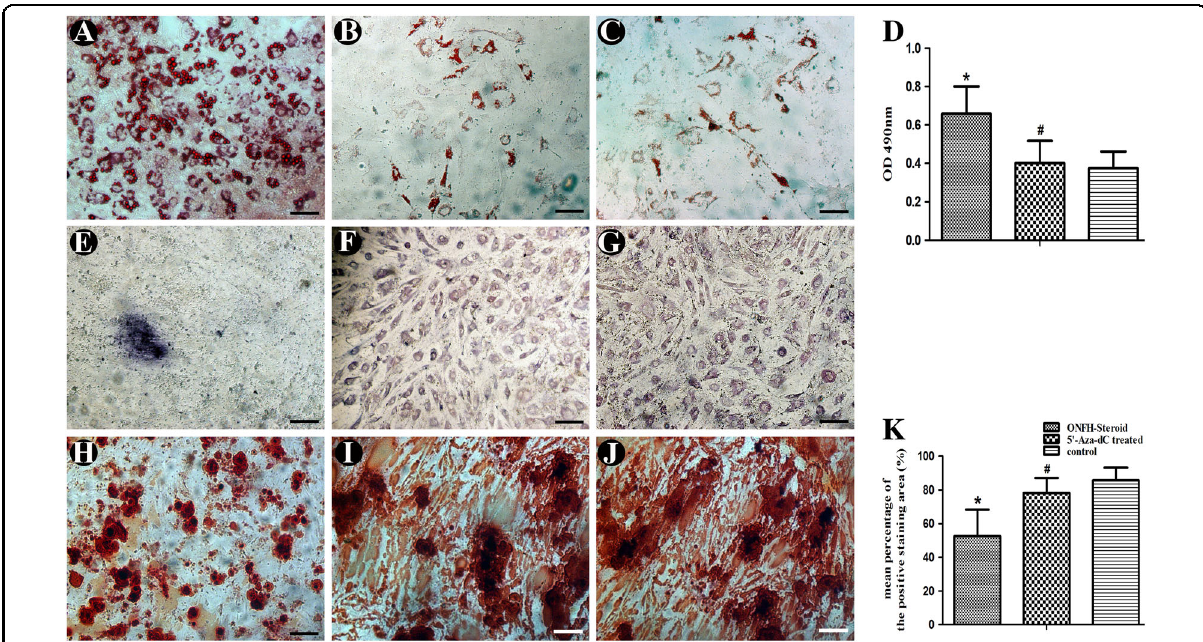
Fig. 3 Adipogenic and osteogenic differentiation. MSCs from all groups were induced to adipocytes and osteoblasts for 21 days. a Oil red O staining of the ONFH group. b Oil red O staining of the 5 ’ -Aza-dC group. c Oil red O staining of the control group. d Incorporated Oil red O was extracted with isopropanol, and quanti fi cation was performed as described in the “ Methods ” section. e BCIP/NBT staining of the ONFH group. f BCIP/ NBT staining of the 5 ′ -Aza-dC group. g BCIP/NBT staining of the control group. h Alizarin red S staining of the ONFH group. ( i ) Alizarin red S staining of the 5 ’ -Aza-dC group. j Alizarin red S staining of the control group. k The area stained with alizarin red S was measured as described in the Methods.